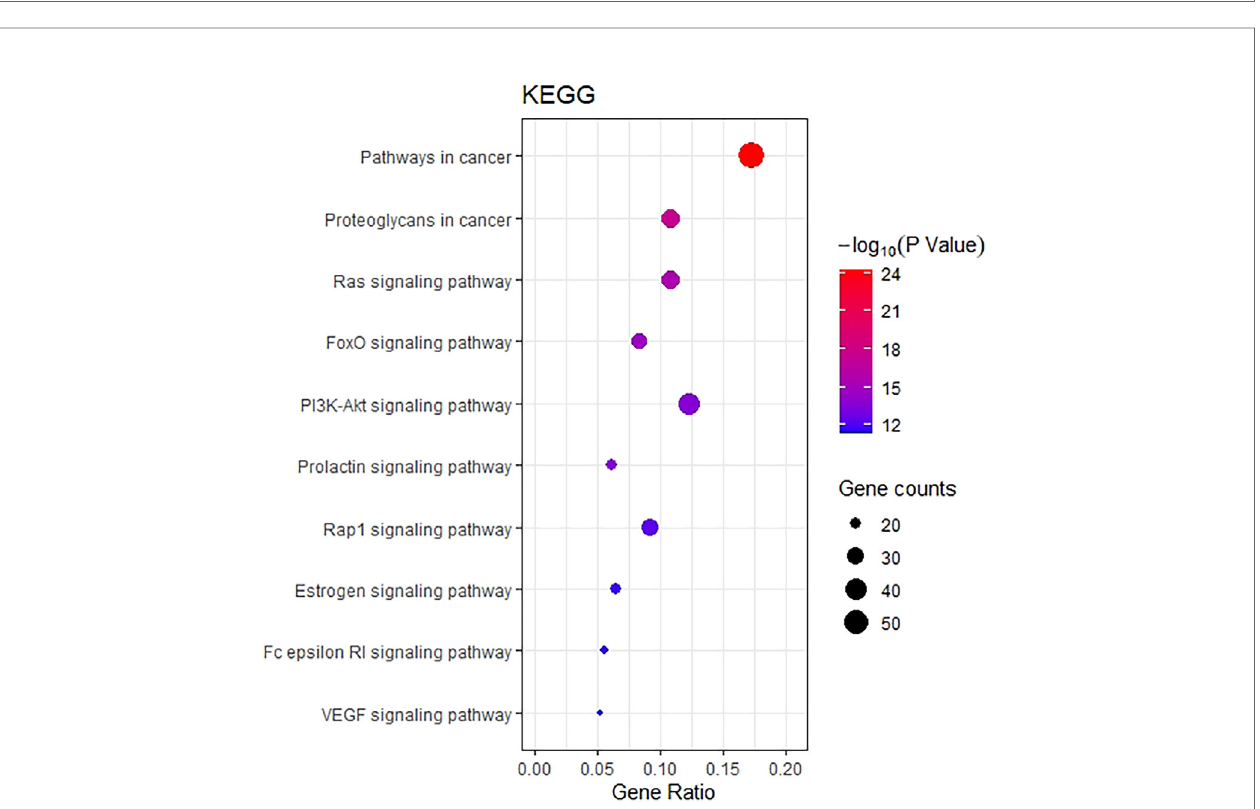
FIGURE 6 | Bubble Diagram of KEGG enrichment of potential targets from the THSWD for treatment of breast cancer. The larger the number of enriched targets, the larger the dots; the larger the P value, the bluer the dot color.